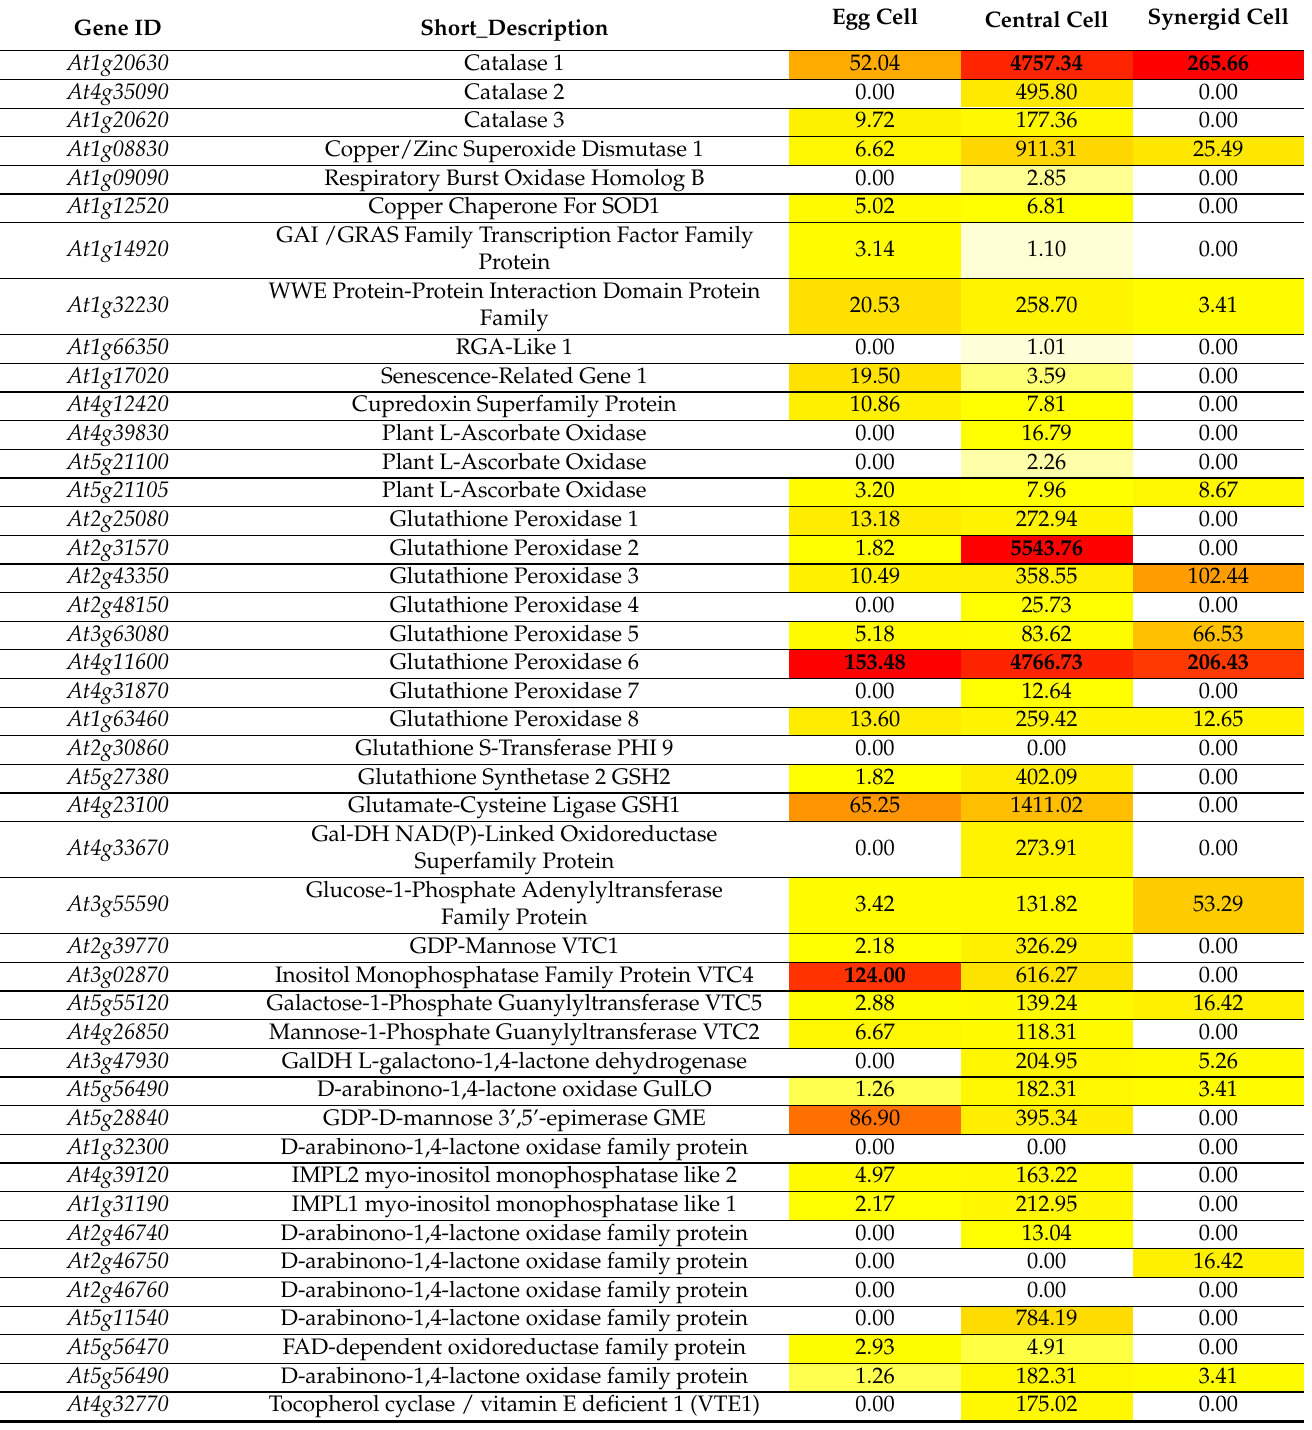
Table 2. Expression of the genes involved in ROS metabolism in Arabidopsis female gametophyte cells; the data for selected genes were extracted from Table S1 of reference [217] and presented as Supplementary Table S1. The average gene expression value was calculated for each cell type. Red, high expression level; yellow, medium expression level; white, no expression detected; on a relative